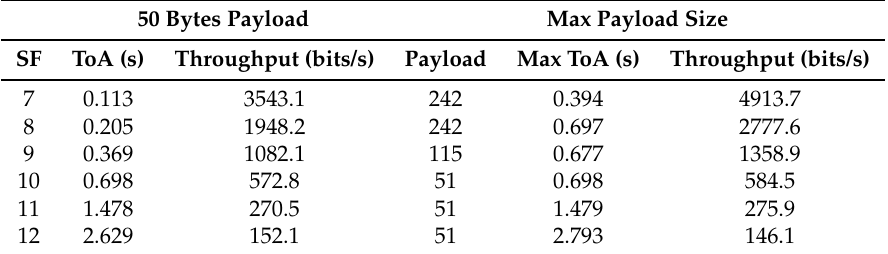
Table 1. Relation between Spreading Factor (SF), throughput, and Time on Air (ToA).